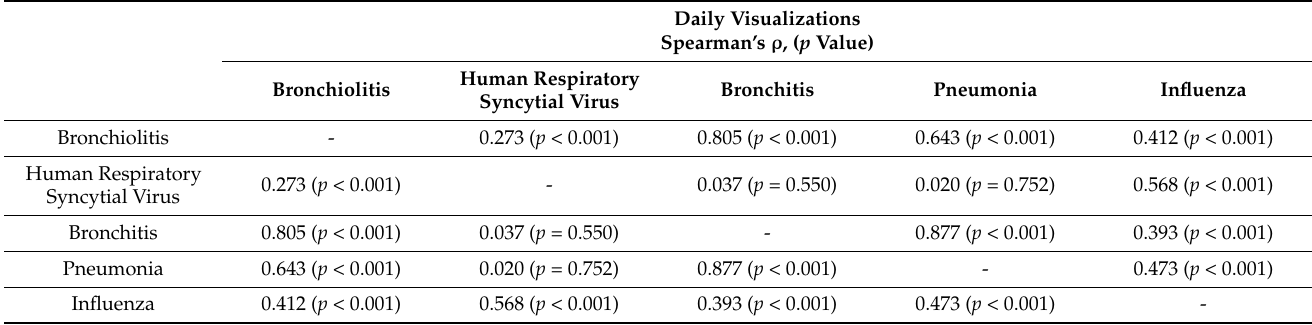
Table A4. Correlation between weekly volume searches on Italian